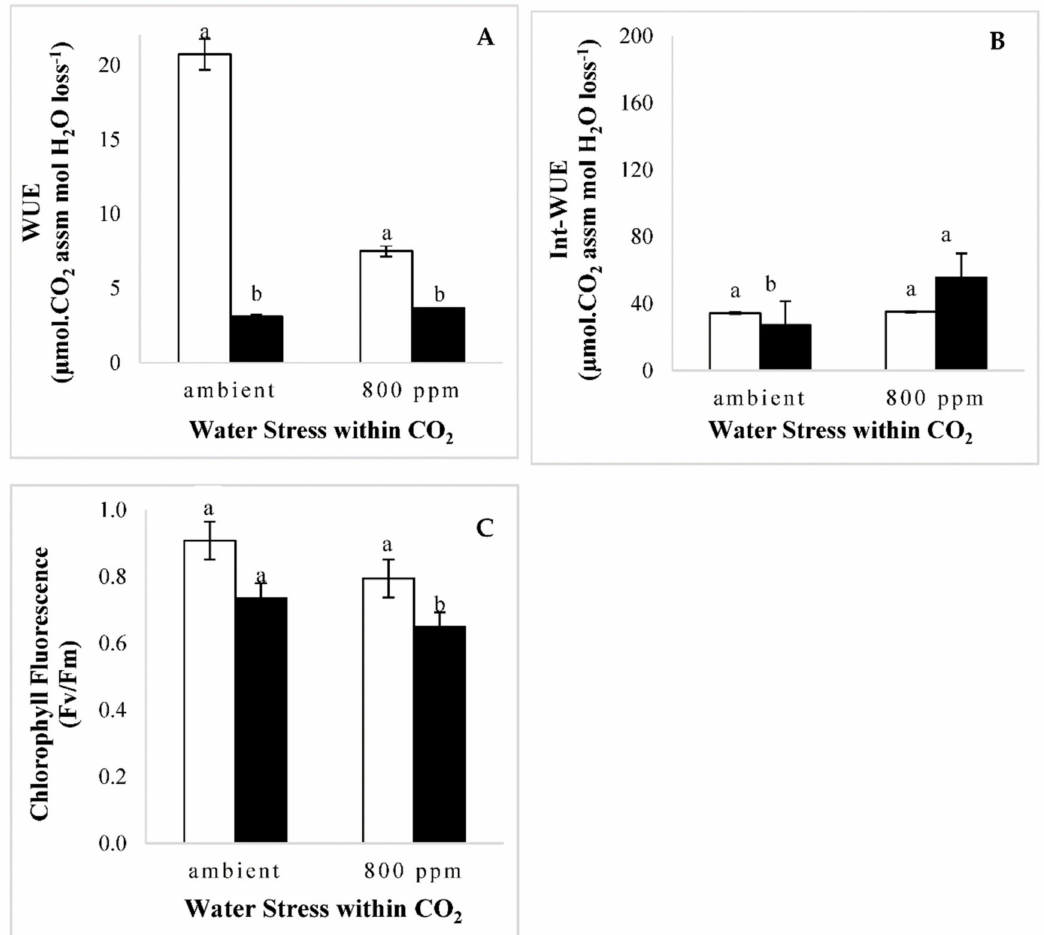
Figure 2. Effect of water stress within CO 2 levels with brassinolide application on Ficus sp. leaf gas exchange: ( A ) WUE treatment of water stress within CO 2 at third MAT, ( B ) int − WUE treatment of water stress within CO 2 at first month after treatment (MAT), and ( C ) F v /F m treatment of water stress within CO 2 at third MAT. Empty bars are well − watered, and black bars are drought stressed. Bars represent means ± SD. Bars with different letters were significantly different by Fisher’s LSD at p <